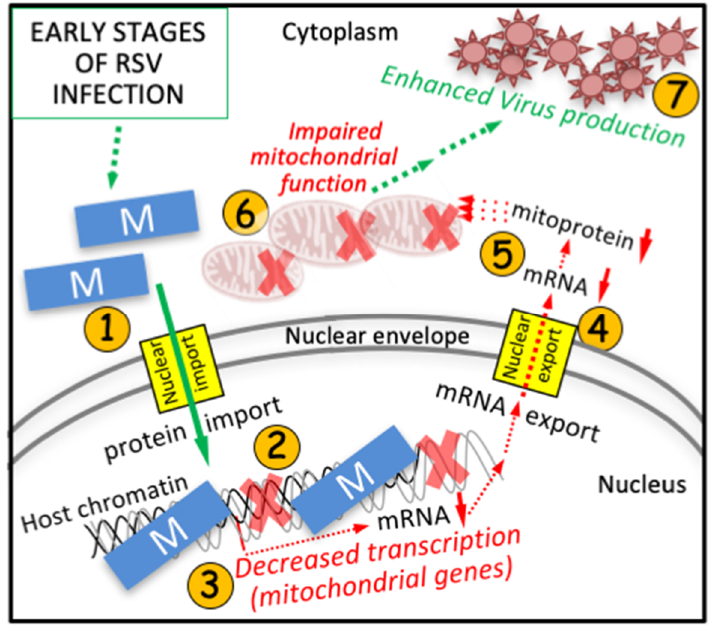
Figure 8. Novel mechanism by which RSV M inhibits host cell transcription through associating with cell chromatin. Key events early in RSV infection are shown, where host functions are indicated by red arrows, and events favoring viral infection are indicated by green arrows; dotted arrows denote multiple steps in the processes. After transport into the nucleus ( 1 ) [12], M associates with host cell chromatin ( 2 ) to suppress host cell transcription globally [49,51], with specific effects on nuclear-encoded mitochondrial genes ( 3 ). This results in reduced mRNA for mitochondrial gene products able to ( 4 ) be exported to the cytoplasm, leading to critical changes to the mitoproteome ( 5 ) [54,55], and severe impacts on host mitochondrial function ( 6 ) [50,56], which ultimately favor infectious virus production ( 7 ) [50,56]. Various agents that prevent RSV’s effects on the mitochondria reduce infectious virus production (not shown—see [50,56]. For early stages of RSV infection prior to M accessing the nucleus (not shown) see Hu et al. [51]; later in infection, M is exported to the cytoplasm to help coordinate nascent virion assembly (not shown) [4,6–9,14,51]. Intriguingly, the role of M in this context resembles in part that of the bacteriophage λ Cro repressor, which acts to turn off early gene expression during the virus lytic cycle [57–60]. RSV M, like Cro, inhibits viral gene transcription, but in the case of RSV, this embodies